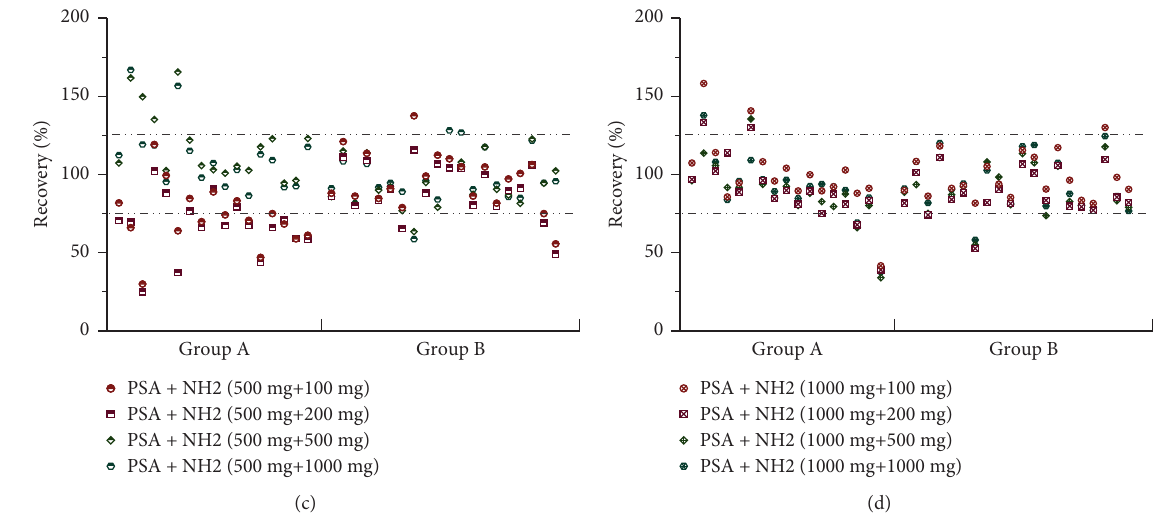
Figure 3: Effect of PSA and NH 2 combination ratio on pesticide recovery.